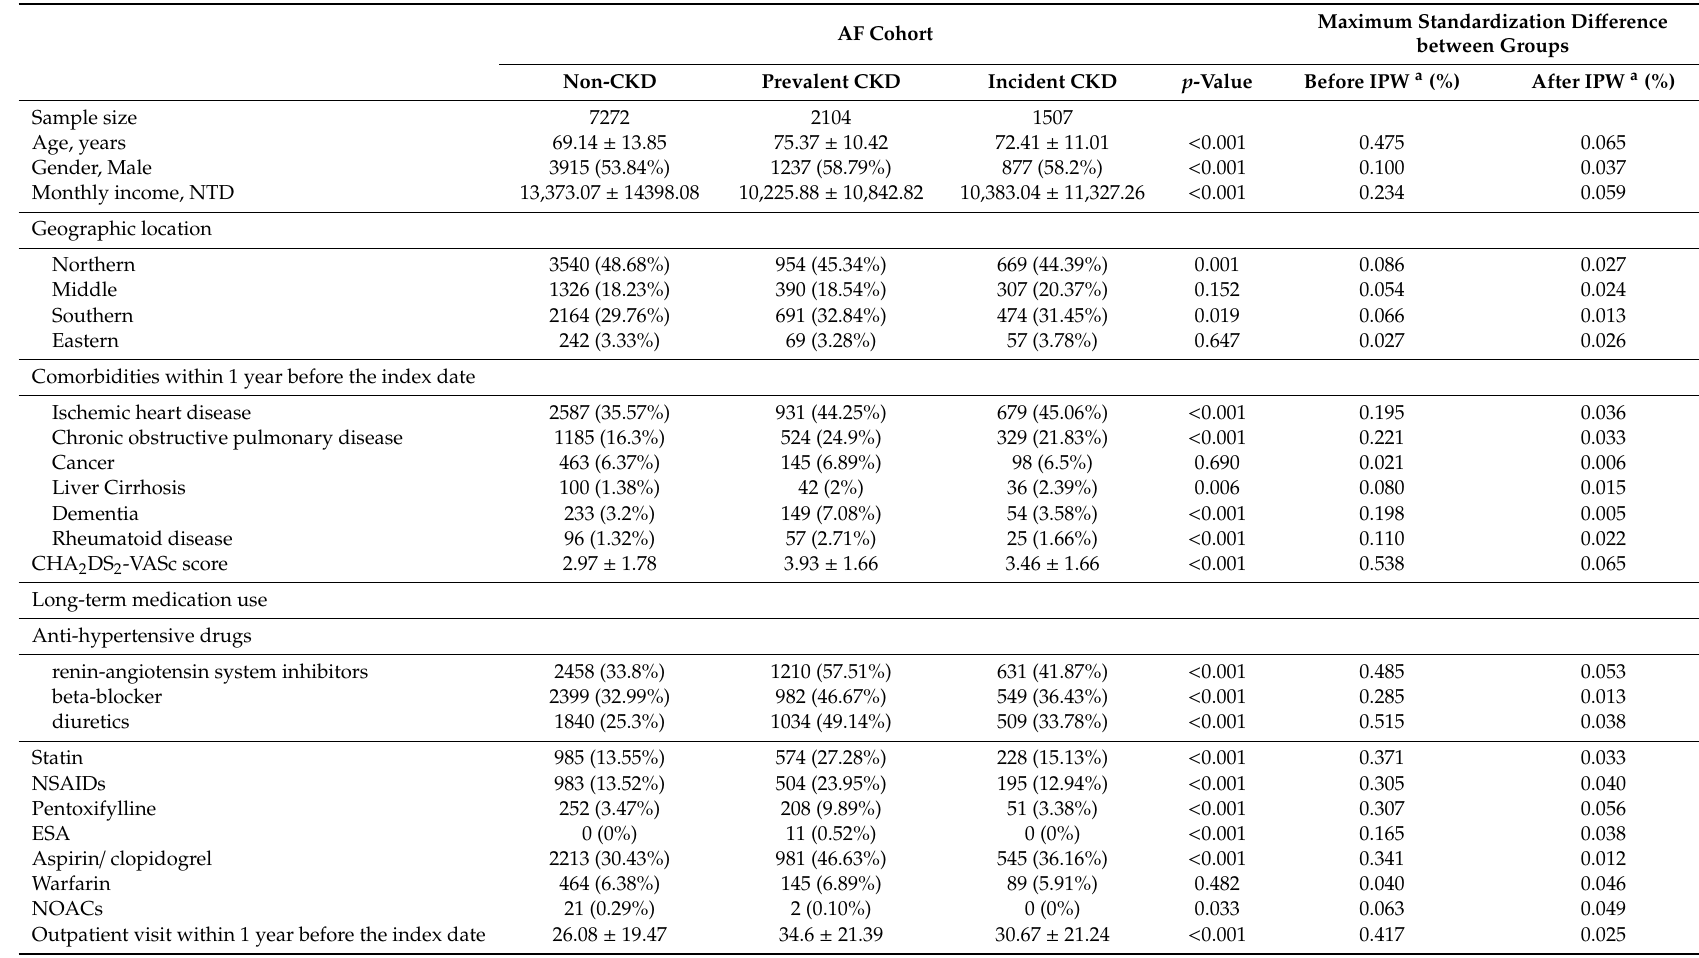
Table 1. Baseline characteristics of study population between the CKD